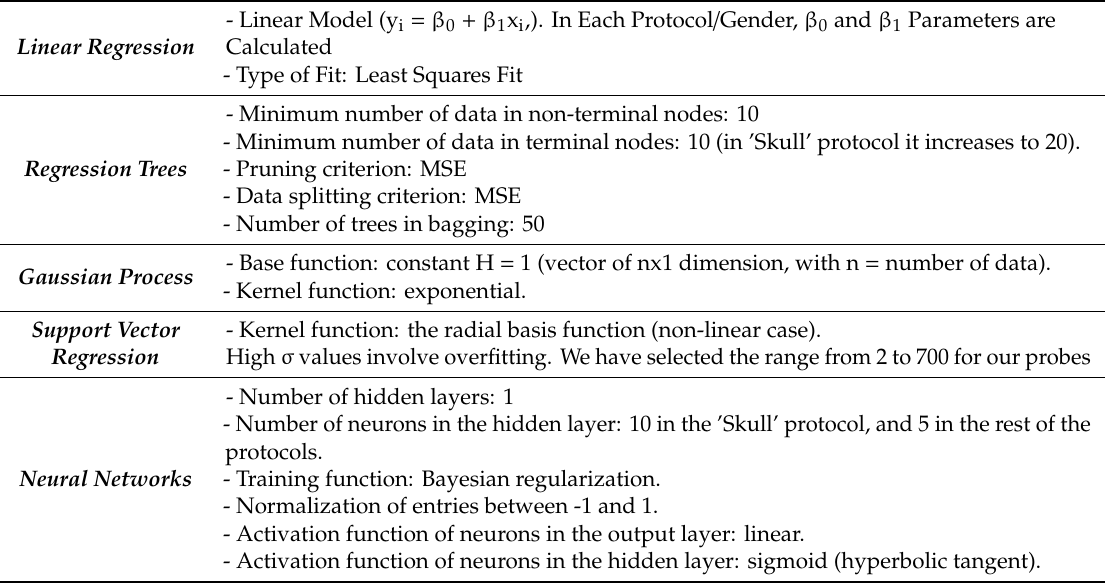
Table 3. Machine Learning (ML) Technique